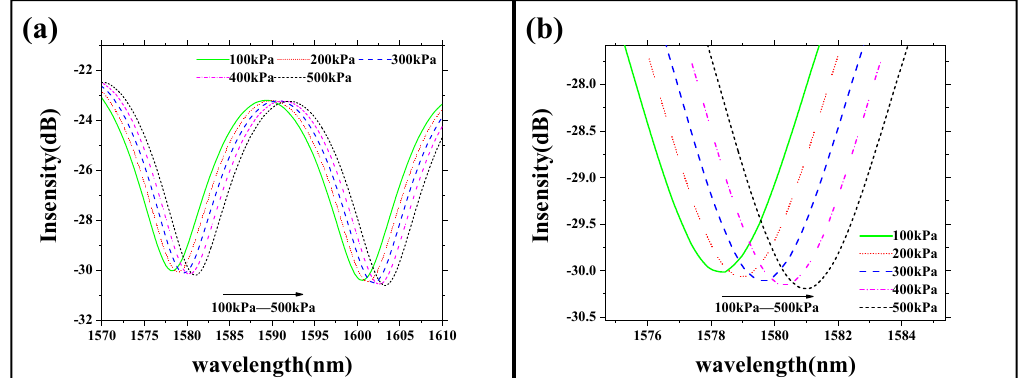
Figure 9. Interference spectrum movement under pressure change of 100~500 kPa: ( a ) interference spectra at the 40 nm band; and ( b ) local enlargement of one interference spectrum.